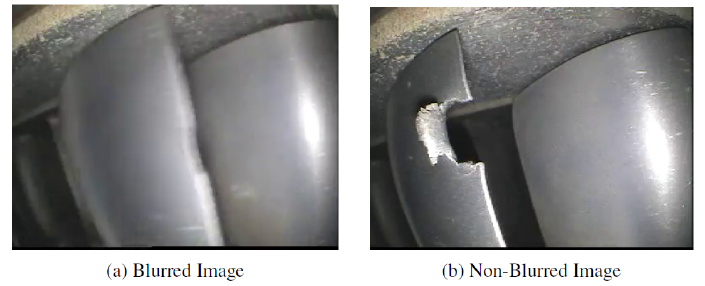
Figure 4. Motion blur in the input